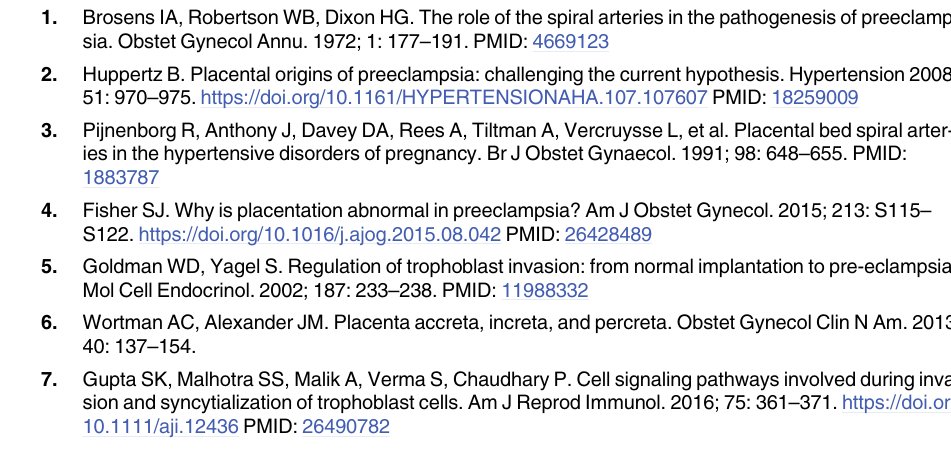
S3 Fig. Inhibition of ERK½ phosphorylation by U0126. Representative blots showing effect of U0126 pre-treatment on phosphorylation of ERK½ with or without EGF treatment in HTR-8/SVneo cells. S4 Fig. Transcript levels of STAT1 after silencing. Bar graph represents transcript levels of STAT1 mRNA by qRT-PCR in naïve, scrambled and STAT1 siRNA transfected cells either in presence or absence of